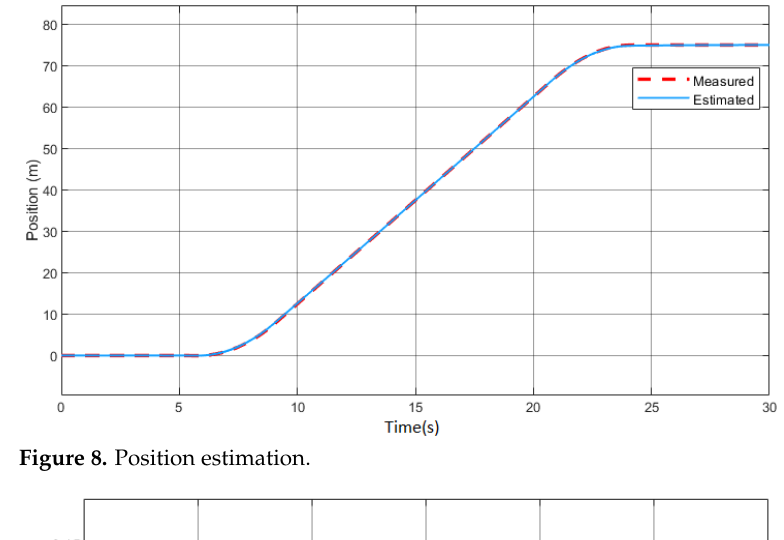
Figure 8. Position estimation.